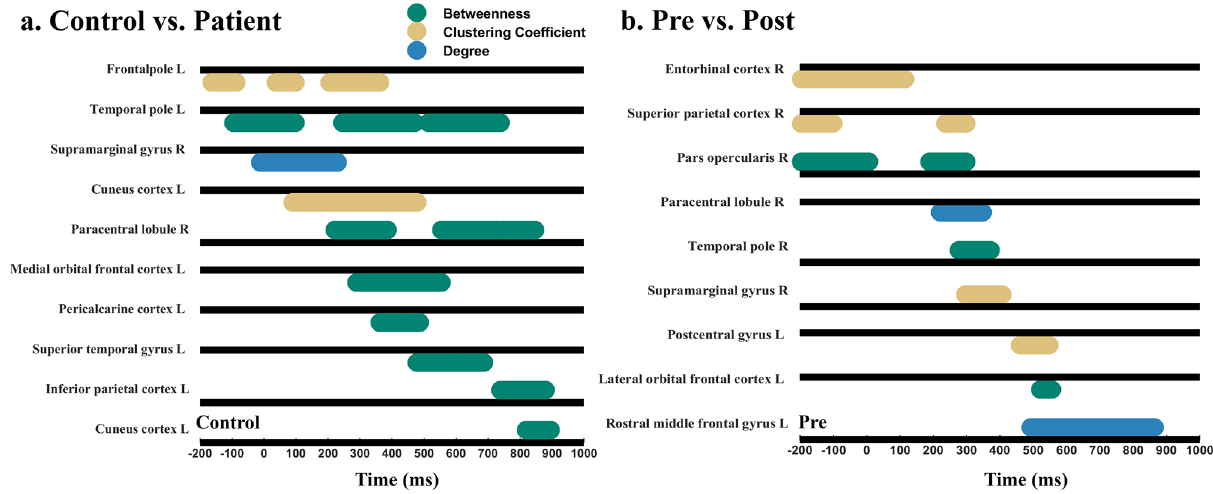
Figure 4. Significant node centralities as a function of the network state. Significant node centrality dynamics for different brain regions as a function of time in reference to stimulus onset (0 ms) during the visual detection task. The black line is the respective reference value for the control group ( a ) or the pre-rtACS group ( b ). The colored horizontal bars display time windows of significant differences between groups (p < 0.05) (green: betweenness; yellow: clustering coefficient; brown: degree). Whereas activation increases are plotted above the respective reference line, activation decreases are plotted under the line. ( a ) The differences of local